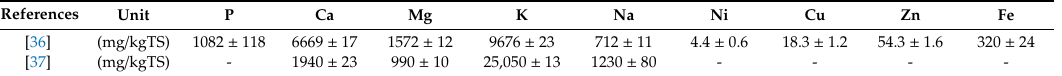
Figure 2. Statistical evaluation of RS characteristics reported in the literature. “n” is the number of values to calculate the median, maximum, minimum, and quartiles [10,26,28,36–42]. Other nutrients and TEs, like Phosphorus (P), Calcium (Ca), Magnesium (Mg), Potassium (K), Sodium (Na), Nickel (Ni), Copper (Cu), Zinc (Zn), Iron (Fe), etc., are usually not analyzed in the RS, except in two studies (Table 2). Table 2. Nutrients and TEs in RS reported in the literature. (“ ± “ stands for the standard deviation of the mean as reported by the authors).